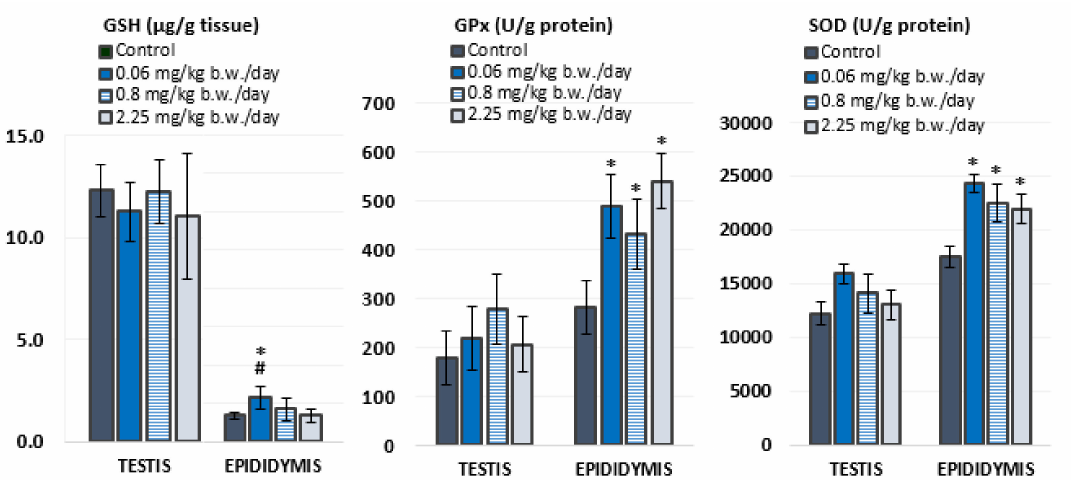
Figure 1. Absolute and relative weights of the left testis and epididymis of Wistar rats (N = 5 rats per group) treated orally for 28 consecutive days with imidacloprid at doses of 0.06 mg/kg b. w./day, 0.8 mg/kg b. w./day, and 2.25 mg/kg b. w./day and the respective negative control. Results are presented as means ± standard deviation. Statistical significance was set at p < 0.05. *—vs. negative control, #—vs. dose 0.06 mg/kg b. w./day.